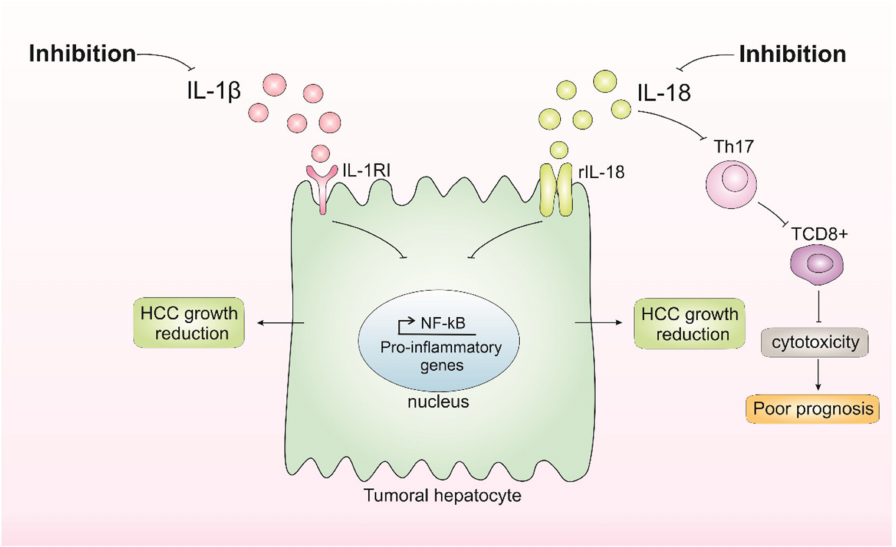
Figure 3. Inhibition of IL-1 β and IL-18 and its consequences in hepatocellular carcinoma (HCC) growth. Inhibition of IL-1 β results in the inhibition of pathways affected by this cytokine, such as nuclear factor kappa B (NF- κ B), which possibly results in the inhibition of tumor growth. Inhibition of IL-18 appears to have dual consequences, either reducing HCC growth or favoring poor prognosis by impairing tumor-infiltration T CD8 +